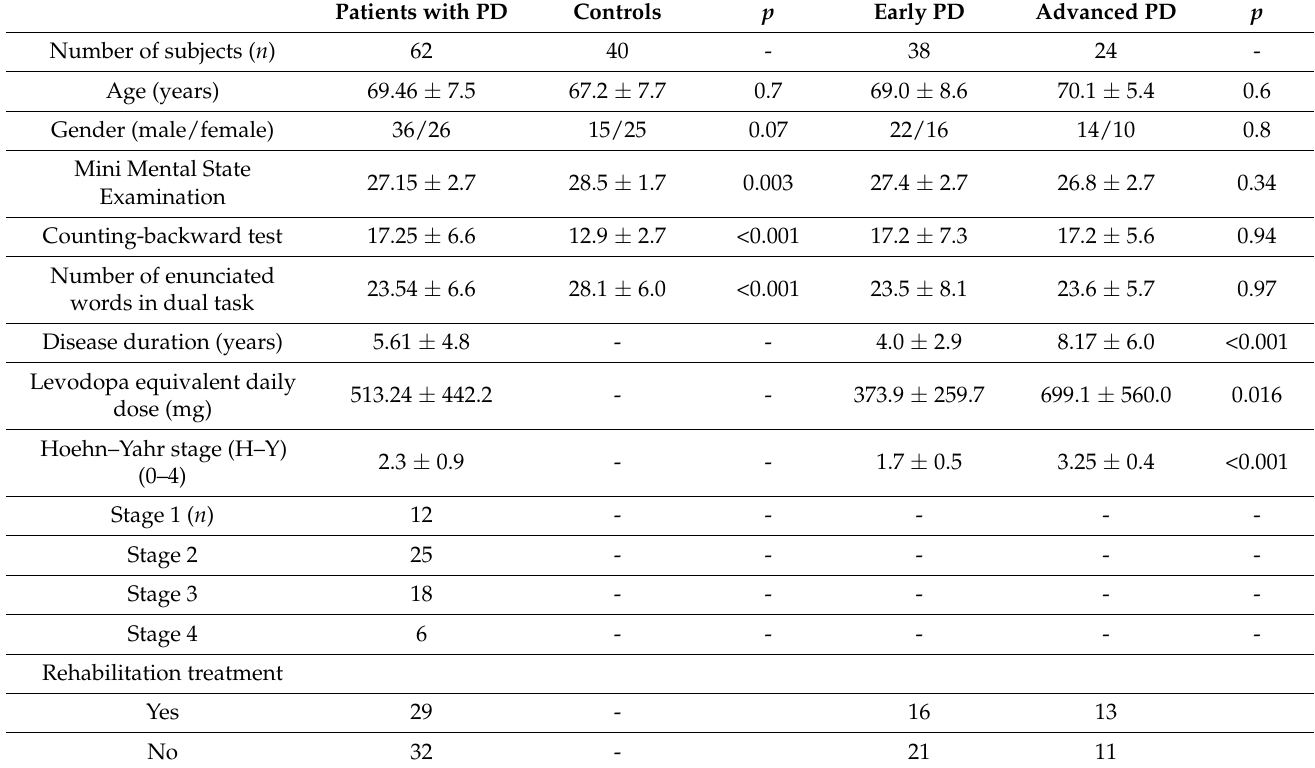
Table 1. Subjects’